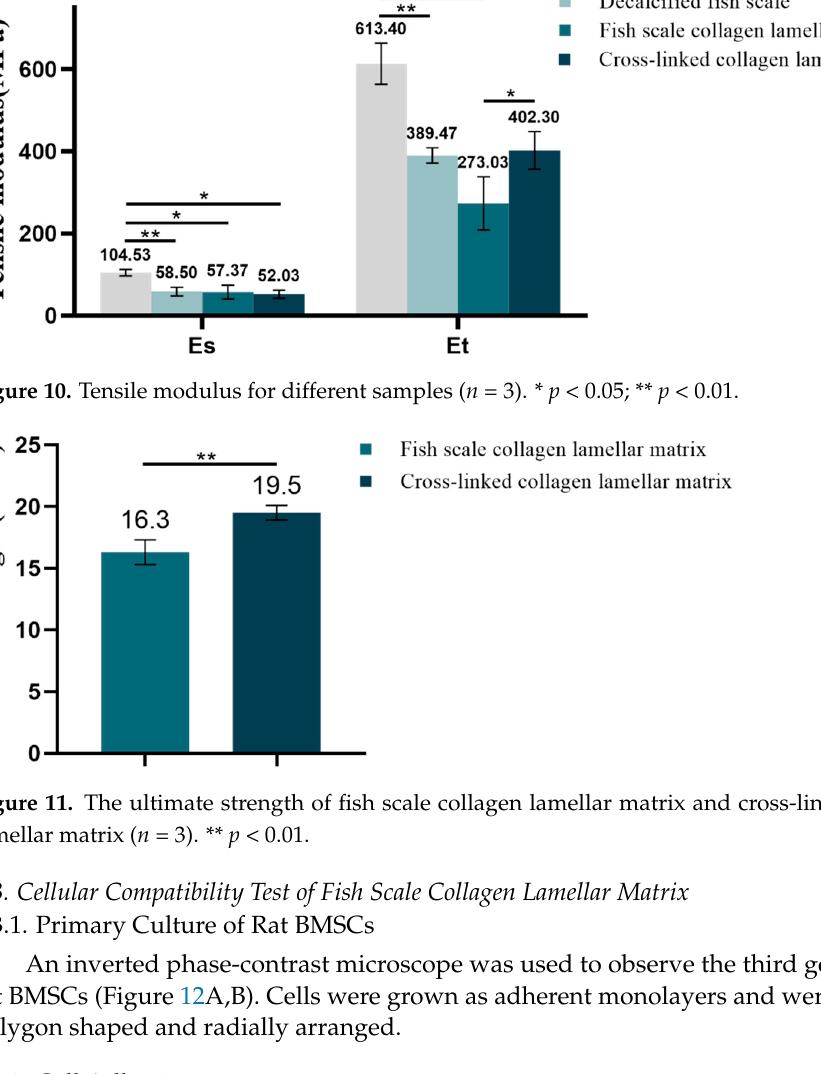
Figure 12. The third generation of primary culture rat BMSCs. ( A ) 40×. ( B ) 100×.